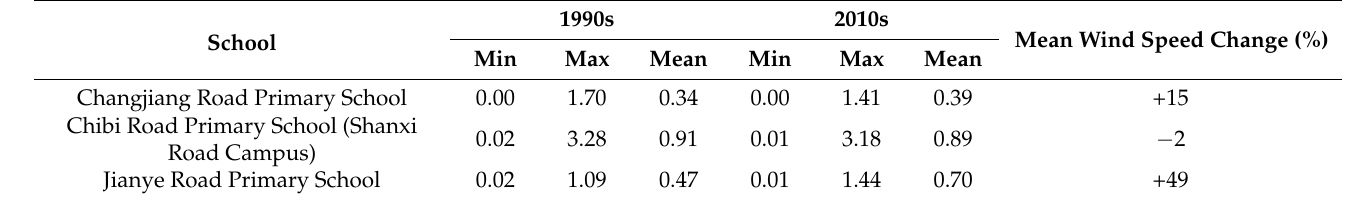
Table 4. Statistics of wind speed at pedestrian level in three primary schools in winter